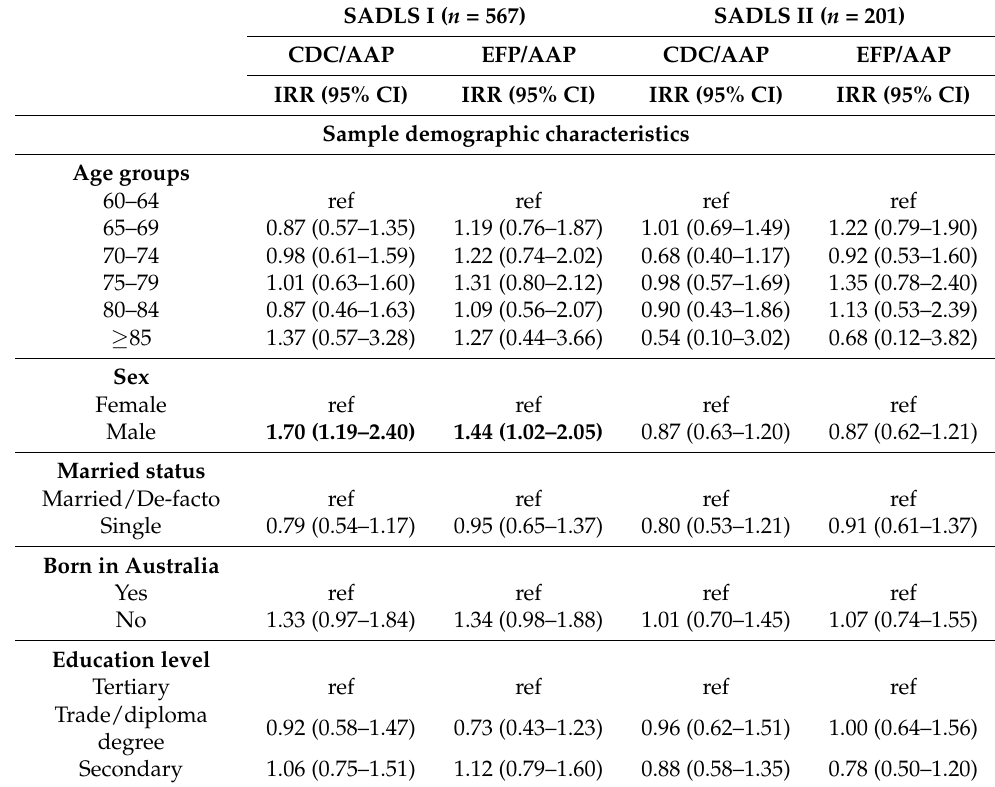
Table 4. Bivariate analysis of the incidence rate ratios (IRRs) of periodontitis under two case definition. SADLS I ( n =